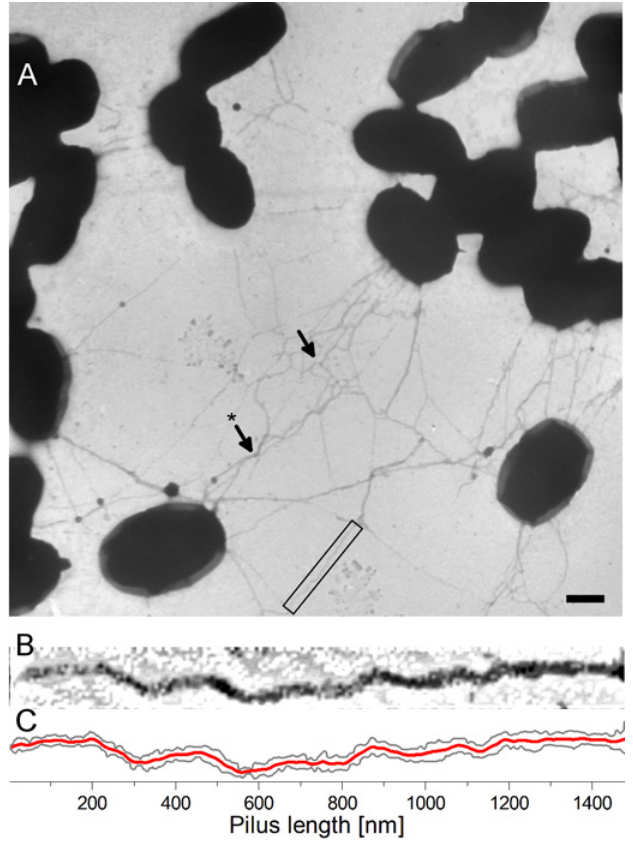
Fig 3. Transmission electron micrograph of Pil strain. (A) Pil strain bacterium (scale bar is 500 nm). A close-up of a pilus (black square) is shown in (B) with higher contrast and (C) image analysis of the